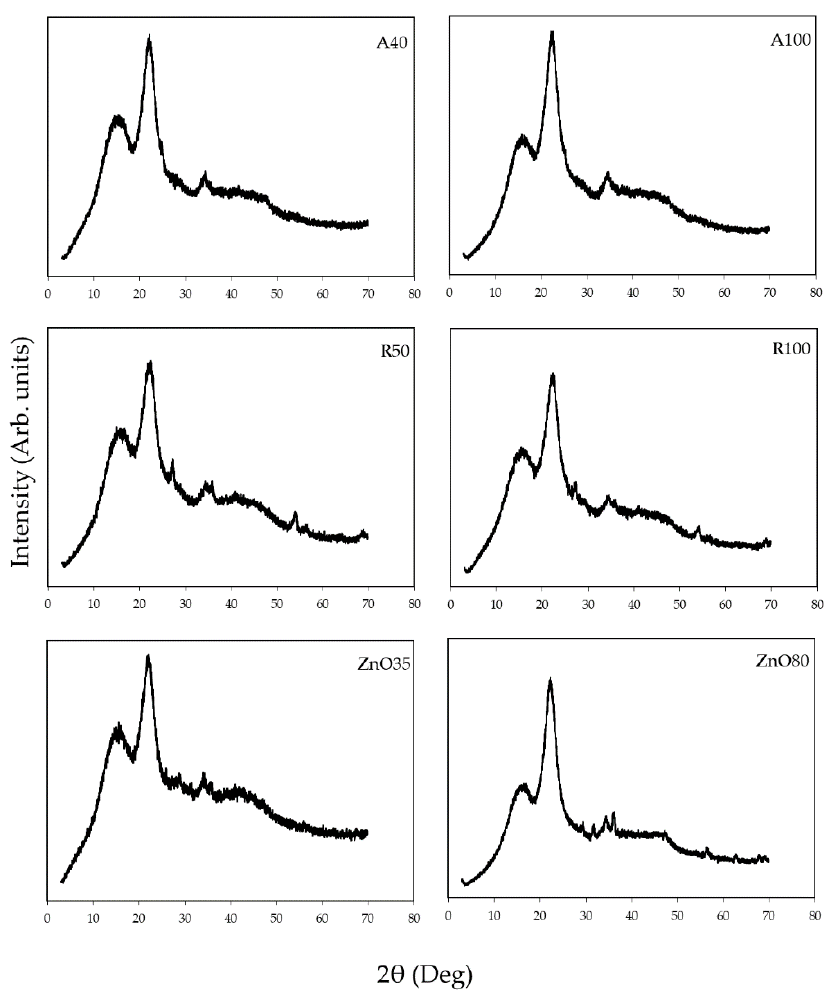
Figure 9. XRD patterns for wood samples treated with anatase 40 nm (A40), anatase 100 nm (A100), rutile 50 nm (R50), rutile 100 nm (R100), ZnO 35–45 nm (ZnO35), and ZnO 80–200 nm (ZnO80). All readings were performed after UV exposure.